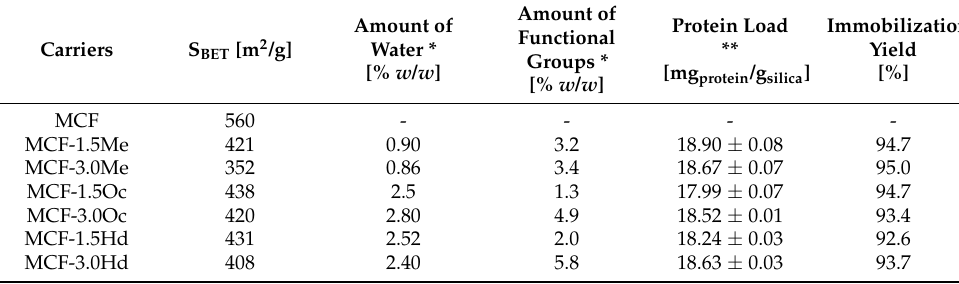
Table 1. Characteristics of